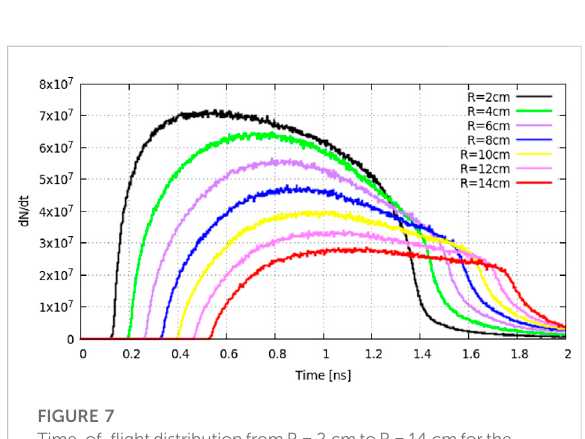
FIGURE 7 Time-of- fl ightdistributionfromR=2 cmtoR=14 cmforthe 0 – 10 MeV